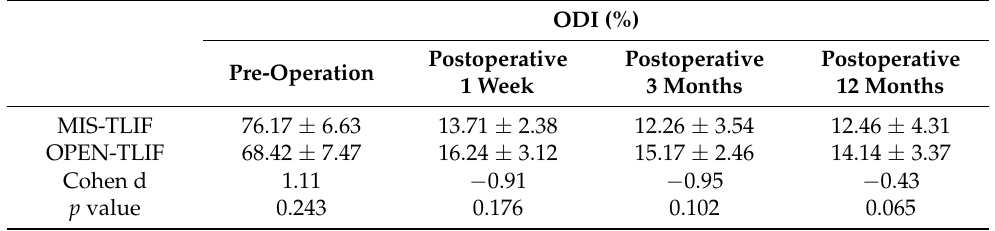
Table 5. Changes in ODI index during the